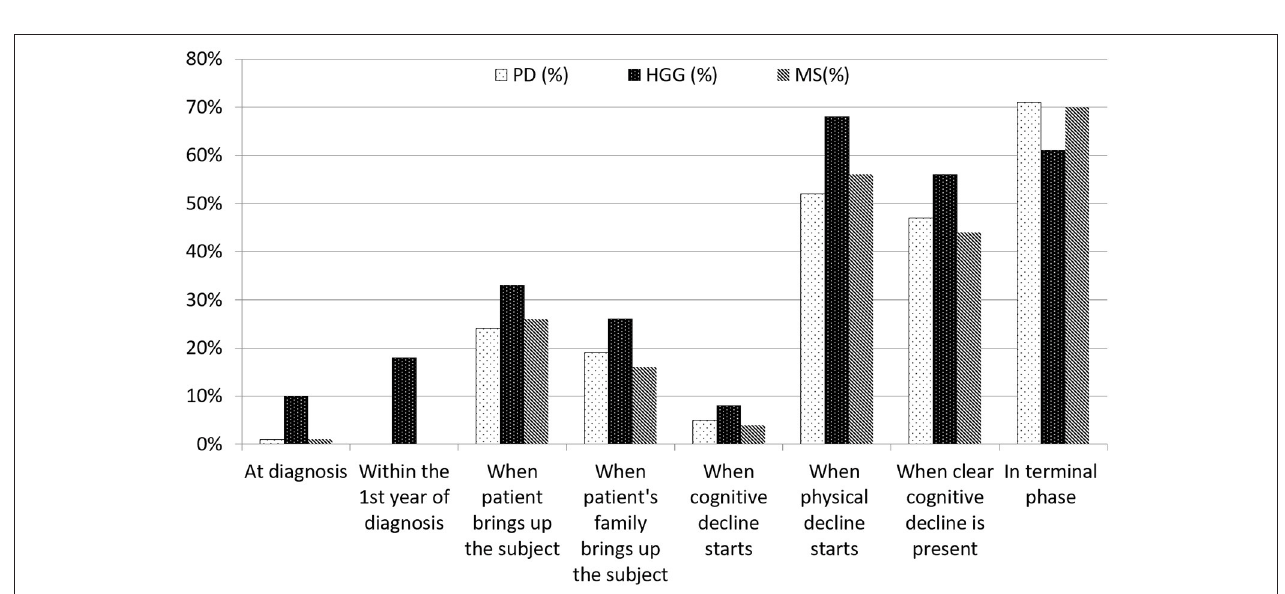
FIGURE 1 | Neurologists and other medical specialists per province, in percentages. Adapted from https://capaciteitsorgaan.nl/app/uploads/2017/04/2017_04_24- DEF-Regionale-spreiding-medisch-specialisten.pdf.